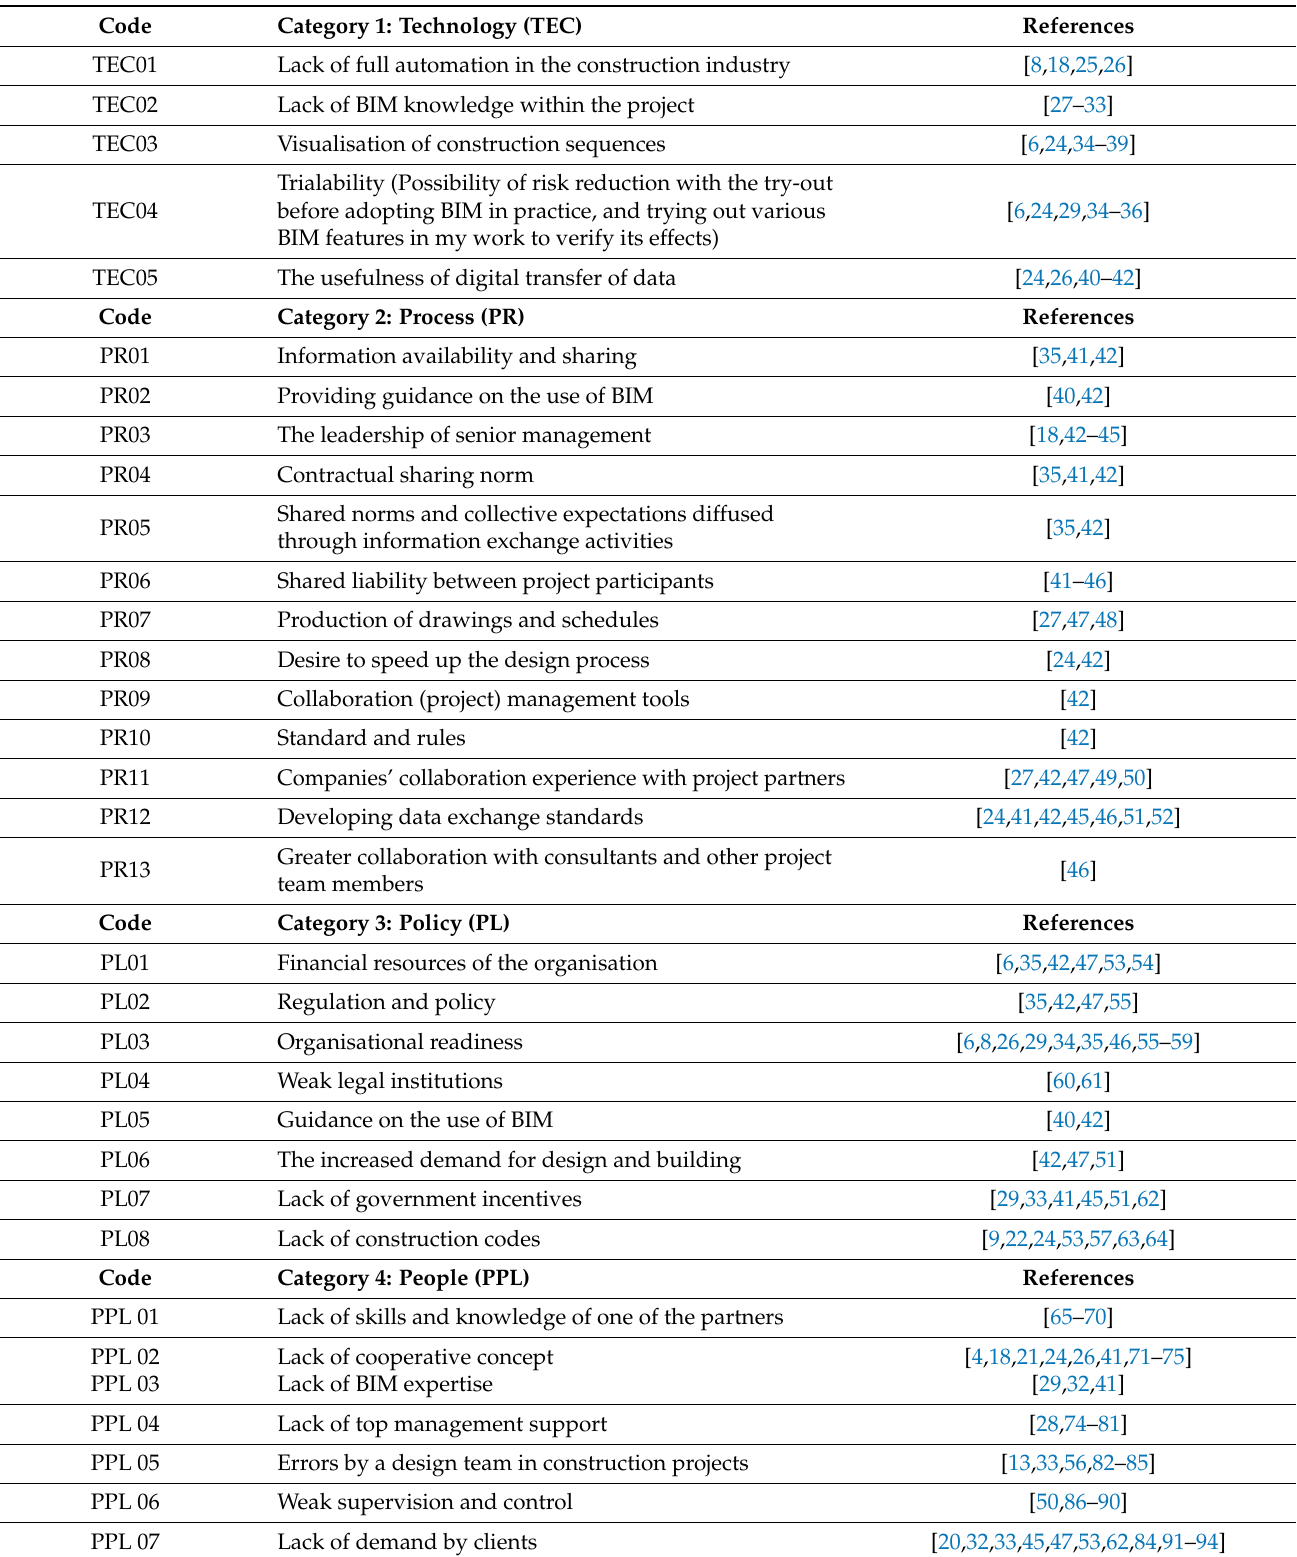
Table 1. Assessment of the factors that influence BIM adoption in the Yemeni construction